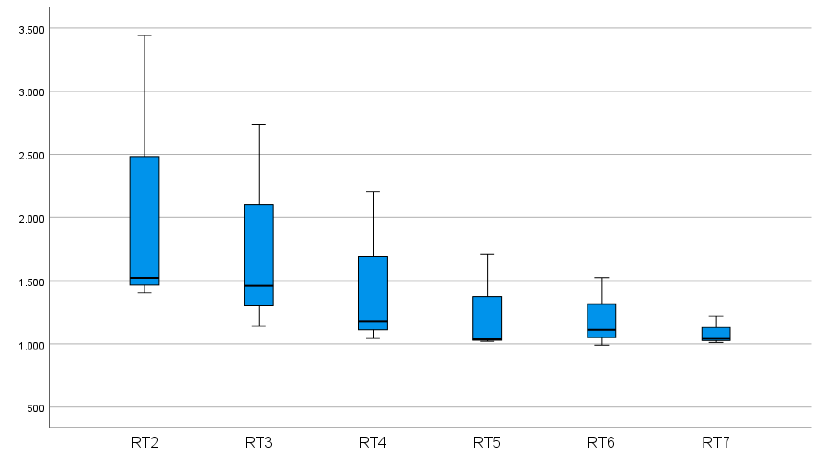
Figure 10. The sum of the reaction times of 10 participants as a function of the stereo acuity level after the training. Forty-sixarcseconds (RT2/level 2) represented the most difficult level and 368 arcsec (RT7/level 16) the easiest level.